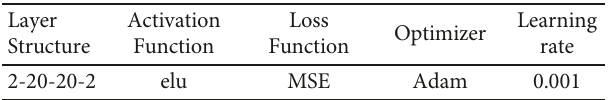
Table 3: Hyperparameter con fi guration of the basic model: fl ow in a cylinder